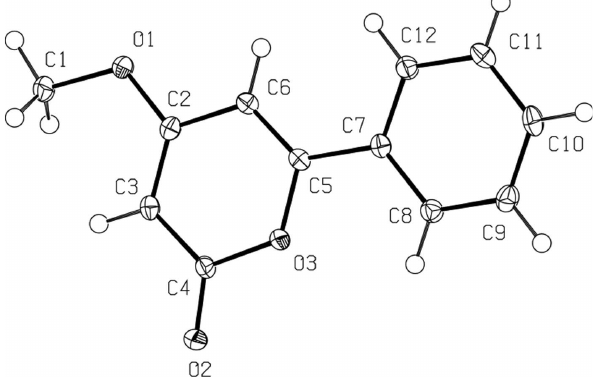
Table 2: Fractional atomic coordinates and isotropic or equivalent isotropic displacement parameters (Å 2